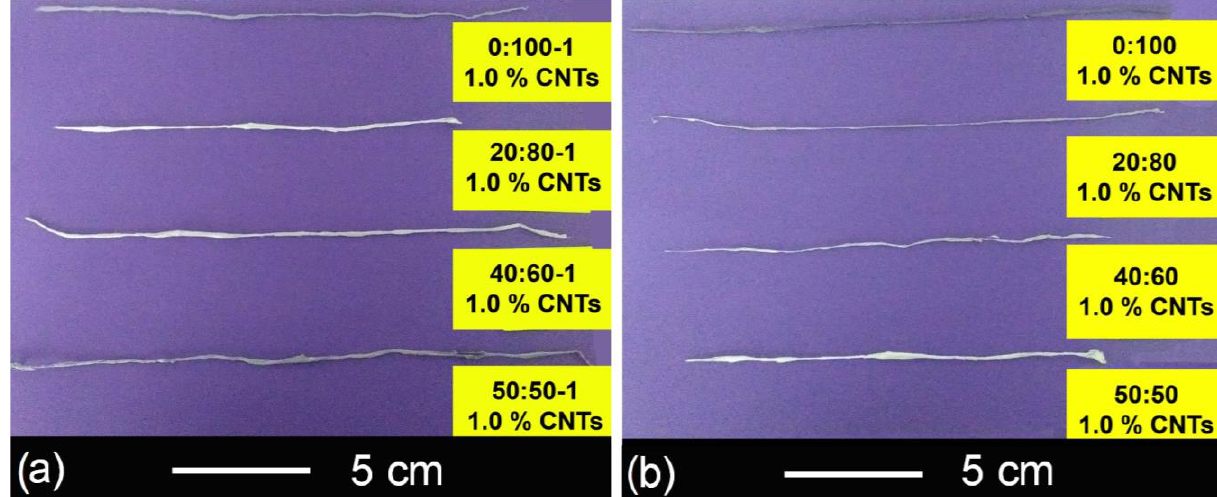
Figure 6. Photographs of composite yarns: ( a ) series SAN/AA1.0 and ( b ) series SAN1.0.